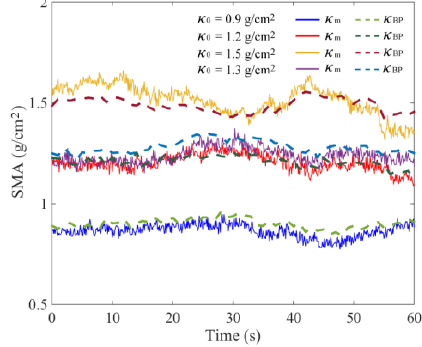
Figure 12. Monitoring results of κ 0 using κ m and κ BP .